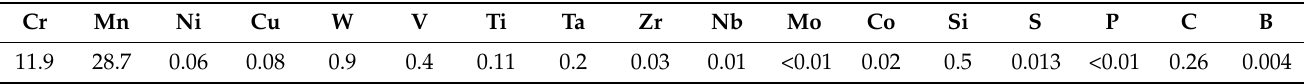
Table 1. Elemental composition of new high-manganese austenitic steel (wt. %, base